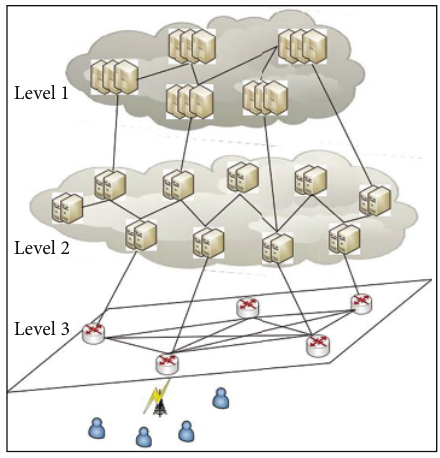
Figure 1: Architecture of future